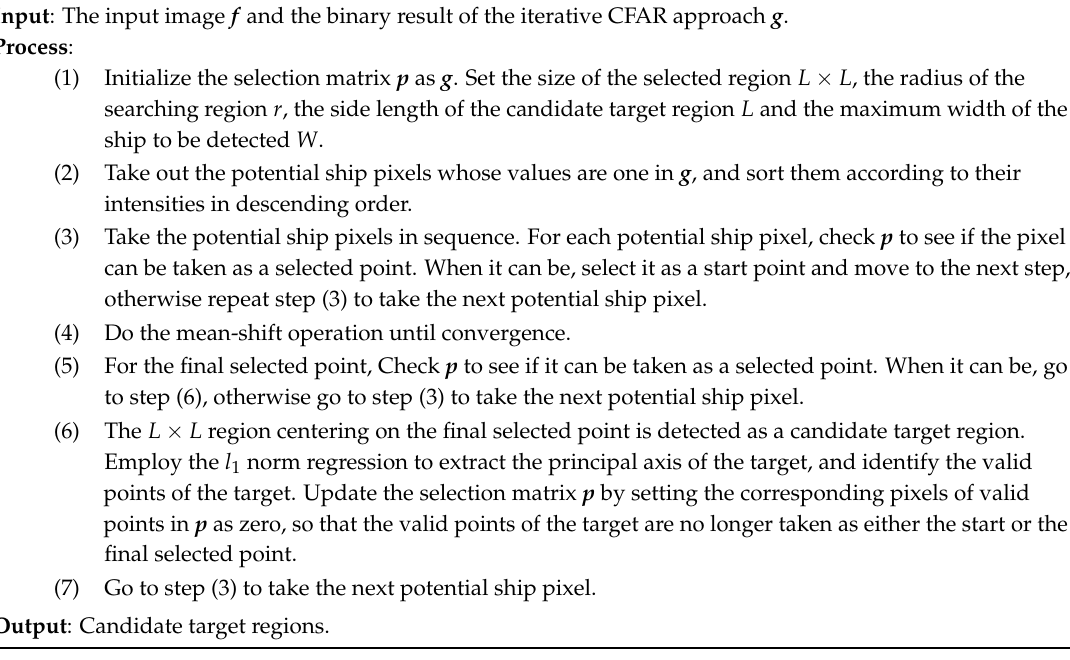
Algorithm 2 Mean-shift Based Candidate Target Region Identification